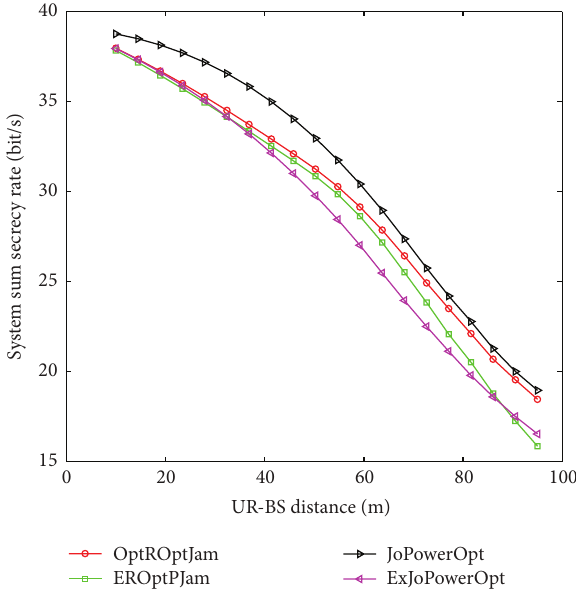
Figure 4: System sum secrecy rate versus UR-BS